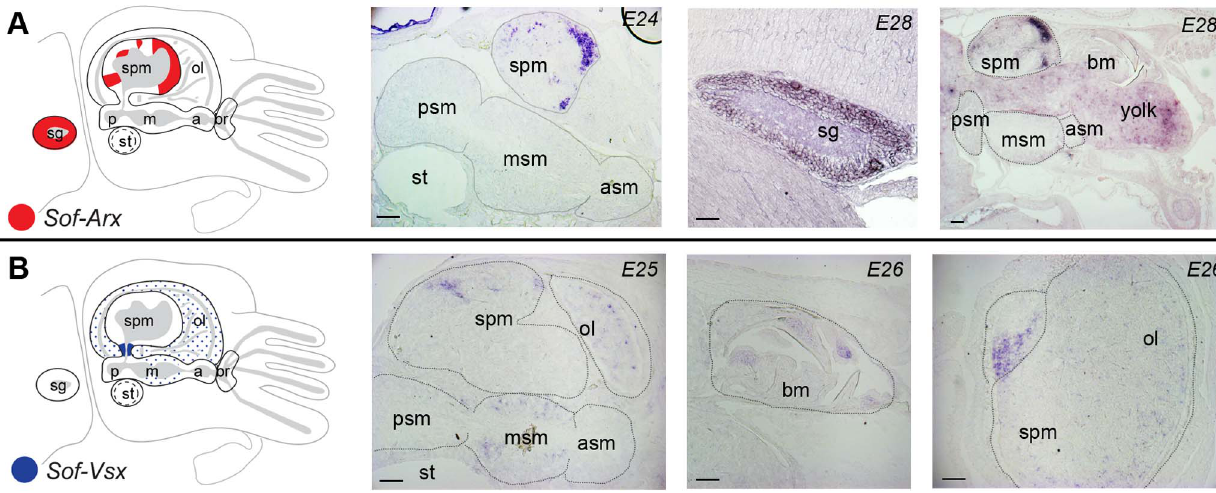
Figure 3. Spatial gene expression profiles of PRD-class homeodomain genes. The first panel of all figures is a schematic diagram as in figure 1, summarizing gene expression domains reconstructed from analysis of serial sections of embryos from stages E24–28. The age of embryo shown is found in the upper right corner of each image. A) Sof-Arx . From left to right: Medial section through the head illustrating expression within the supraesophageal mass; Gene expression within the stellate ganglion; Medial section through the head illustrating retained expression within the supraesophageal mass. B) Sof-Vsx . From left to right: Medial section through the head illustrating expression within cells of the optic lobes, the supraesophageal mass, and the middle subesophageal mass; section through the buccal mass illustrating signal associated with the mesenchyme of the developing beak; medio-lateral section through the head demonstrating gene expression in cells scattered throughout the optic lobes, and within the supraesophageal mass. Abbreviations - asm: anterior subesophageal mass; bm: buccal mass; msm: middle subaosophageal mass; psm: posterior subesophageal mass; st: statocyst; sg: stellate ganglion; spm: supraesophageal mass.